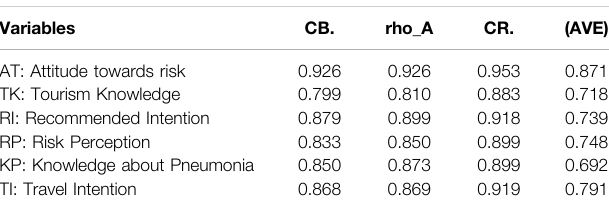
TABLE 2 | Construct reliability and validity. Variables CB. rho_A CR. (AVE) AT: Attitude towards